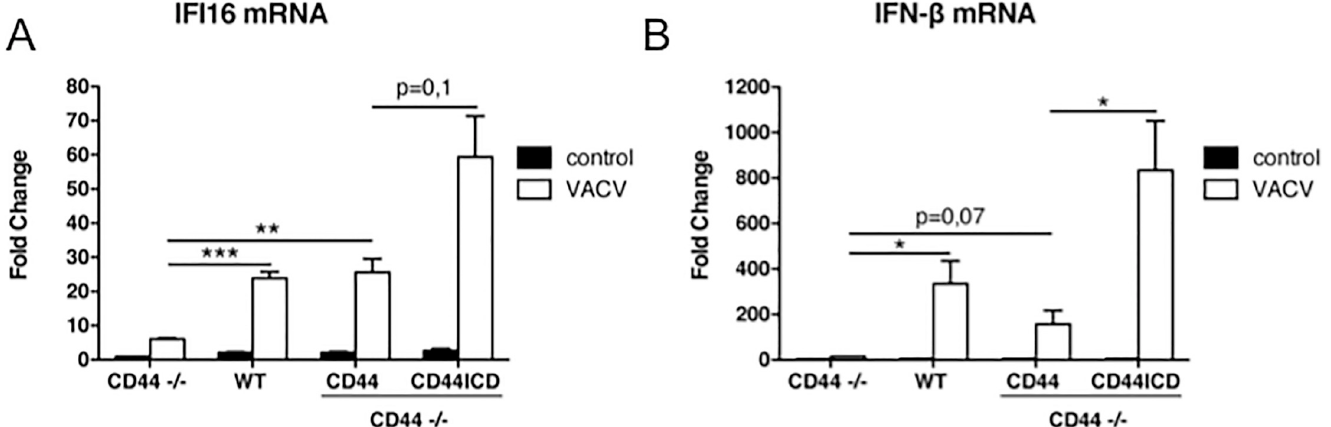
Fig 4. Rescue of viral DNA-induced IFI16 and IFN- β expression by CD44-ICD in cd44 -/- MEFs. MEFs from CD44 complete knockout mice were lentivirally transduced with either CD44 full length or CD44-ICD as described in Materials and Methods. Two days after transduction cd44+/+ and cd44-/- MEFs were transfected with the VACV70mer oligo for 6 h as described in Materials and Methods. RNA was isolated and transcribed into cDNA. cDNA was analysed by RT-qPCR using primers for murine IFI16 (primers 11 and 12, Table 1) and IFN- β (primers 13 and 14, Table 1) and actin for normalization (primers 7 and 8, Table 1). Experiments were done in triplicates. For statistics see Materials and